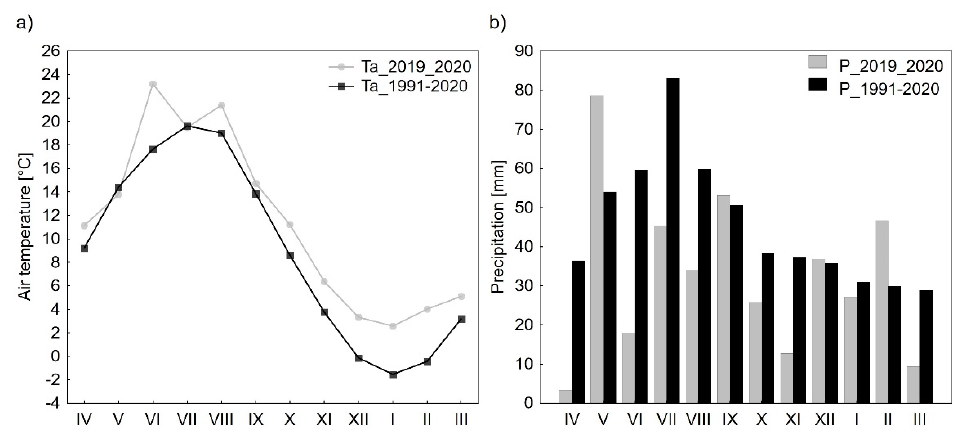
Figure 3. Mean monthly air temperature values ( a ) and monthly precipitation totals ( b ) from April station. Based on data from the Institute of Meteorology and Water Management—National Research Institute.